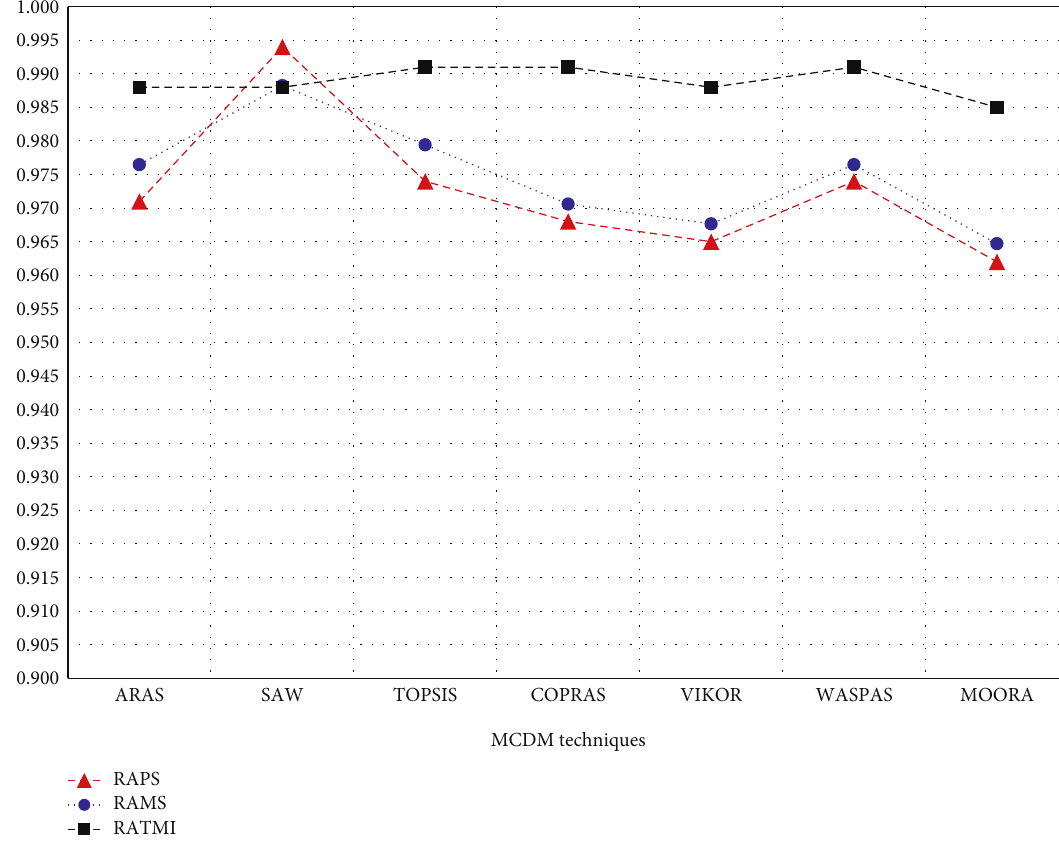
Figure 4: Relative comparison between the two RAMS and RATMI technique and RAPS